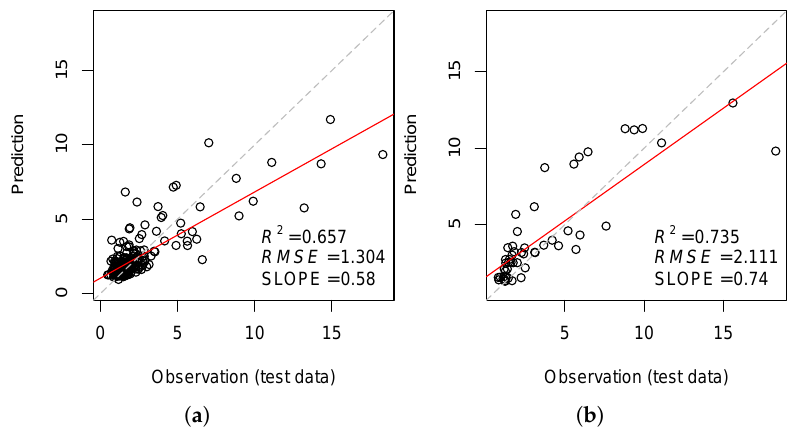
Figure 6. Comparison of independent validation results based on SOC content (%) data sets for entire Bavaria ( a ) and the subset (( b ), cf., Table2). The red line is the regression line of the scatter plot, the gray and dashed line indicates the optimal regression